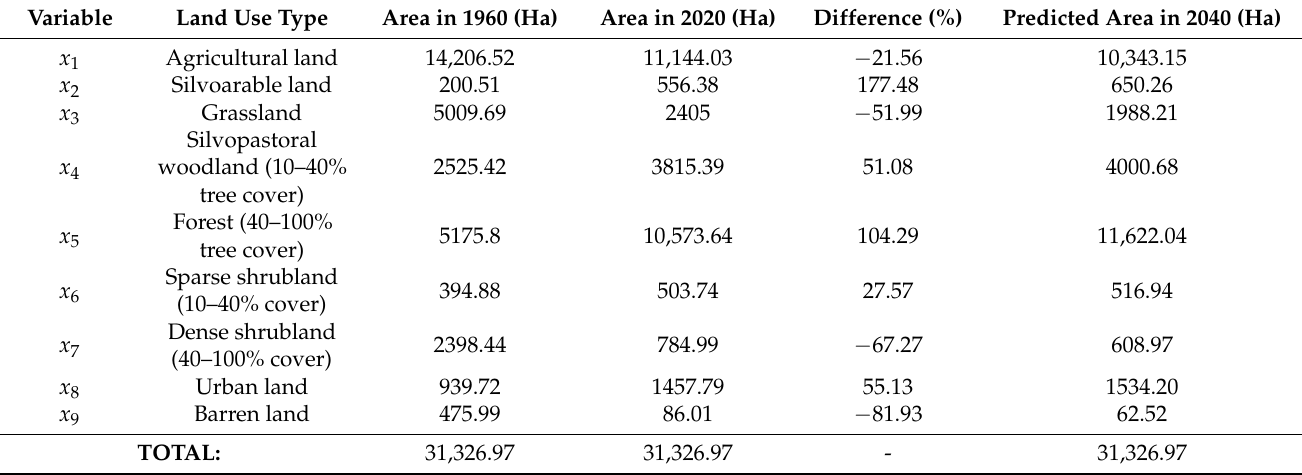
Table 1. Historical, current and predicted area (Ha) in 2040 for the BAU scenario (Municipality of Mouzaki, Greece).